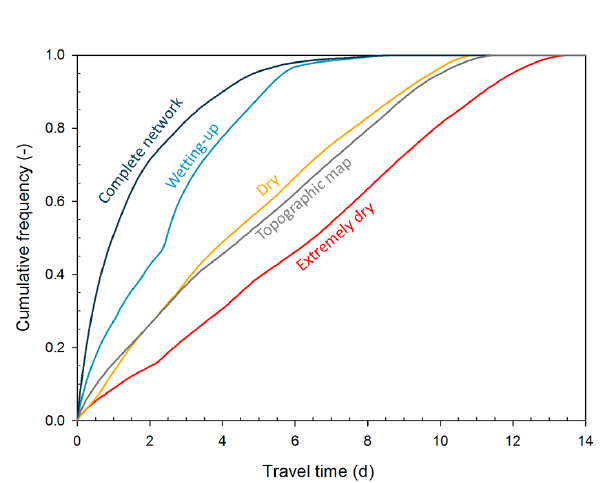
Figure 5. Cumulative frequency distributions of the travel time ( t t ) to the catchment outlet for the five flowing stream networks shown in Figs. 2 and 4. See Table 2 for the main descriptive statistics of the travel time